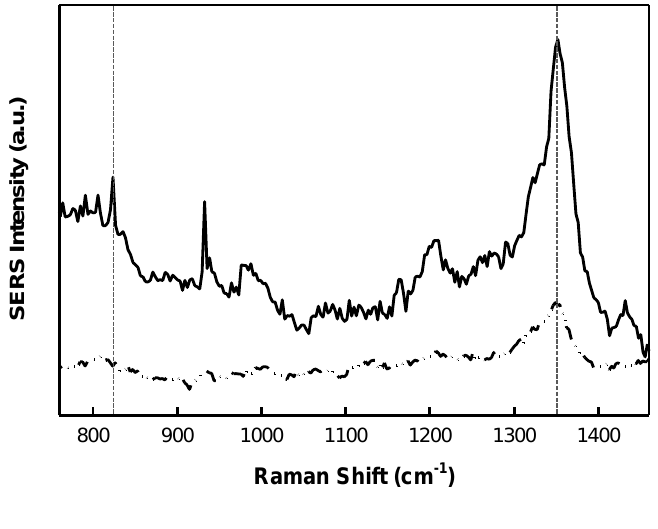
Figure 6. SERS spectra recorded for a TNT-doped xerogel film before (―) and after ( ‒ ∙∙ ‒ ) TNT extraction. Spectra are offset for clarity. The vertical dashed lines indicate the peaks related to TNT, which decreased after template